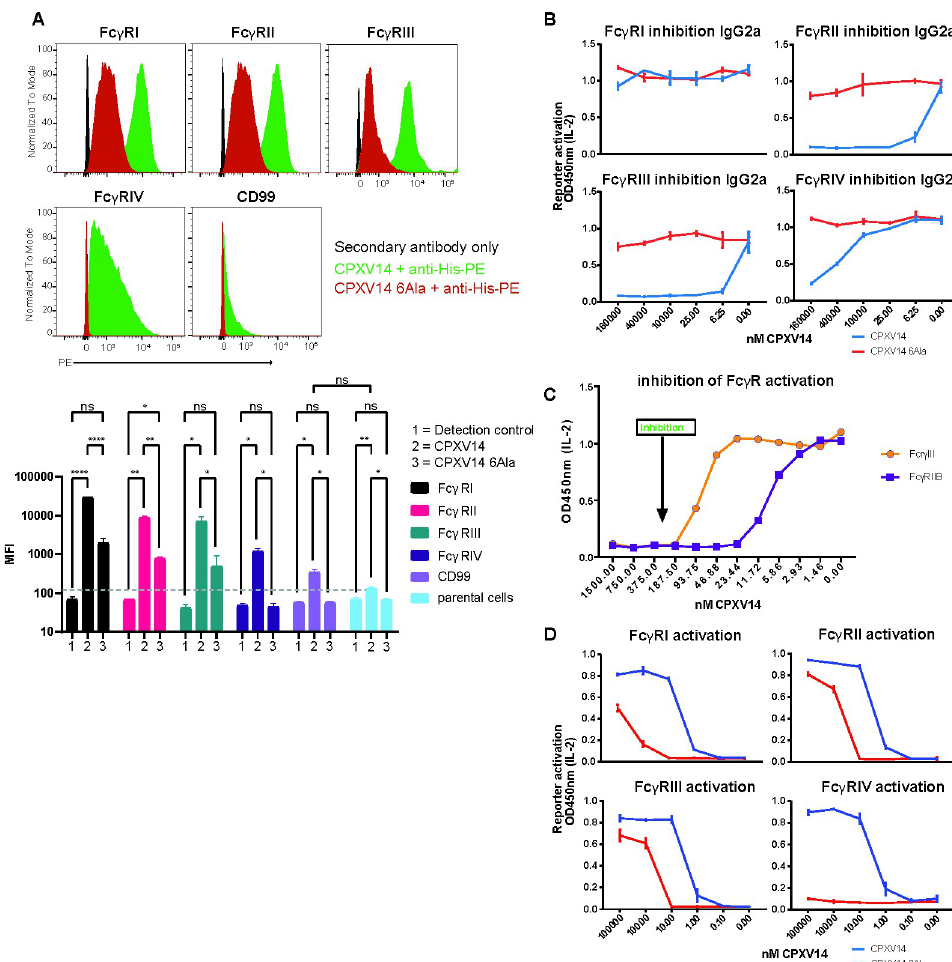
Fig 7. CPXV14 can act as an agonist of Fc γ Rs and antagonist of IgG-dependent Fc γ R signaling. A) CPXV14 directly binds to mouse Fc γ Rs on BW5147 reporter cells. His6-tagged CPXV14 or its 6Ala mutant were incubated with the indicated reporter cells and protein binding was detected via flow cytometry using a PE-conjugated TetraHis-specific antibody. Human CD99 expressing or parental BW1547 cells served as controls. The dashed line indicates background binding to parental cells. The bar graph shows the mean fluorescence intensities (MFI) from three independent experiments. Error bars = SD. 2-way ANOVA (Tukey) ( ��� p � 0.001, �� p � 0.01, � p � 0.05, ns = p > 0.05). B) CPXV14 interferes with IgG-dependent Fc γ R signaling. IL-2 reporter cells expressing the indicated murine Fc γ Rs were added to mouse IgG2A-coated plates in the presence or absence of the indicated concentrations of either CPXV14-His or CPXV14-6Ala-His. The mean and range from two independent experiments (n = 2 each) is shown. C) CPXV14 prevents Fc γ RIIB and Fc γ RIV signaling in response to immune complexes. IL-2 reporter cells expressing murine Fc γ RIV (mCD16) or Fc γ RIIB (mCD32B) were added to a plate coated with immune complexes (TNF α + anti-TNF α ) in the presence of CPXV14-His. Complete inhibition of IL-2 secretion was observed at 187.5 nM and 23.44 nM, respectively. The mean of duplicate measurements is shown. D) Immobilized CPXV14 activates Fc γ Rs. IL-2 reporter cells expressing the indicated murine Fc γ Rs were added to plates coated with the indicated concentrations of CPXV14-His or CPXV14- 6Ala-His. IL-2 secretion indicates direct activation of Fc γ R signaling in response to CPXV14 binding. The mean and range from two independent experiments (n = 2 each) is shown. To determine whether the increased virulence and replication of CPXV14-expressing virus compared to the deletion mutant was a consequence of CPXV14 modulation of Fc γ R function, we monitored virulence in knockout mice that lacked the inhibitory receptor Fc γ RIIB [36]. Fc γ RIIB -/- mice were intra-nasally infected with CPXV, CPXV Δ 12 or CPXV Δ 14 and weight loss and mortality was monitored. Interestingly, mice infected with CXPV Δ 14 displayed